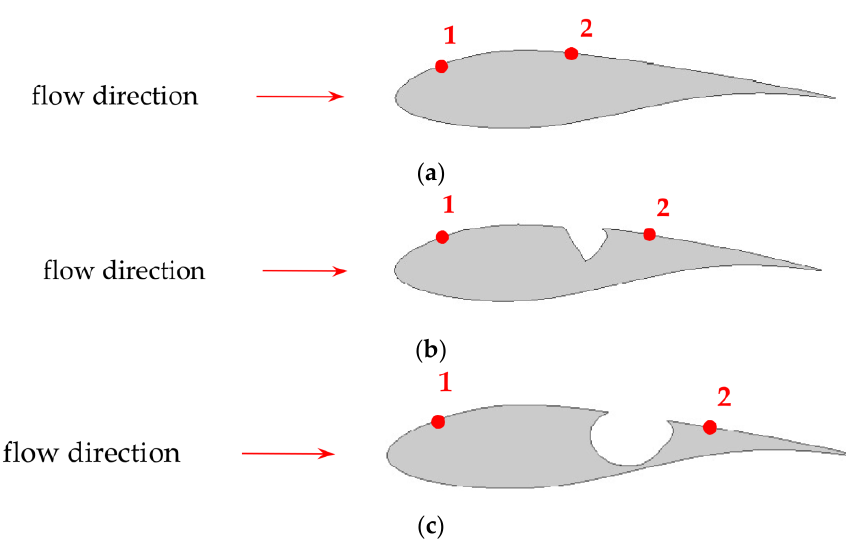
Figure 14. Location of the dye injection holes: ( a ) standard Risø airfoil; ( b ) airfoil with cavity A; ( c ) airfoil with cavity